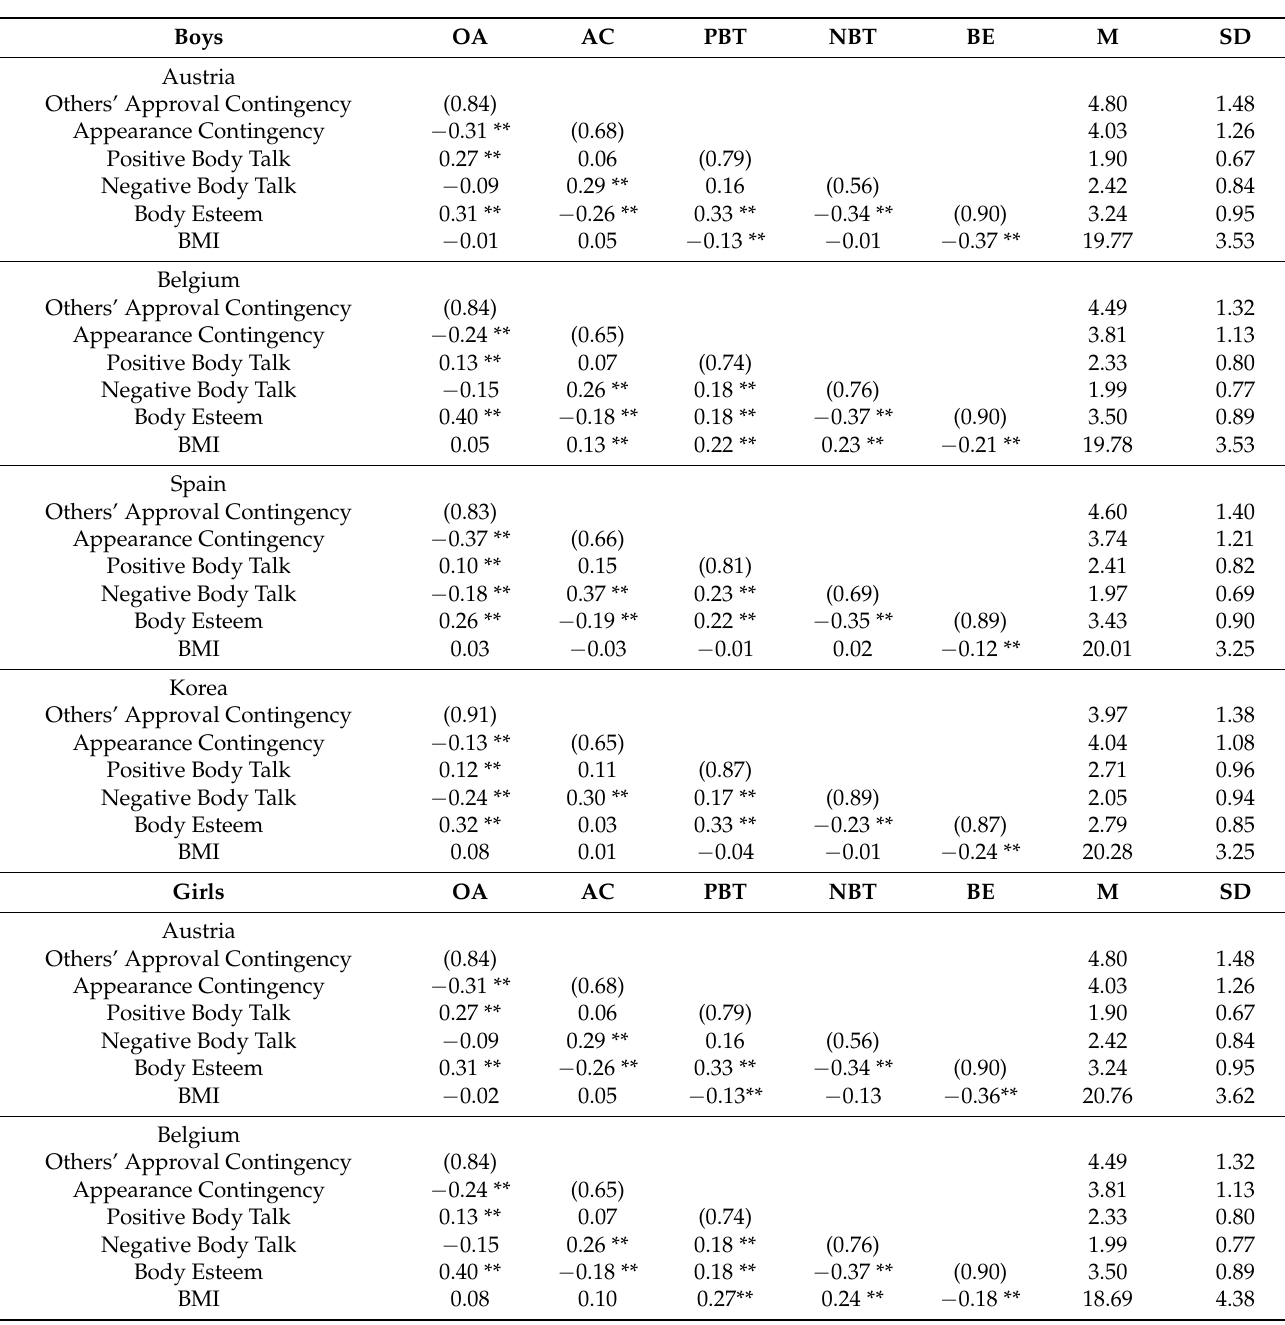
Table 2. Reliabilities, Correlations, Means, and Standard